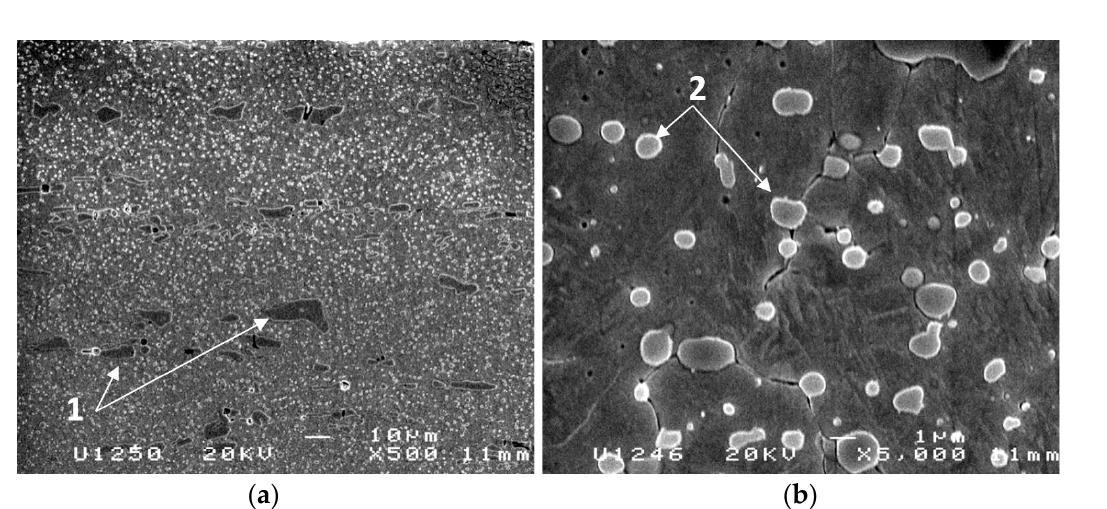
Figure 2. The structure of the material used in research where: ( a ) magnification 500×, 1—primary carbides, ( b ) magnification 5000×, 2—secondary carbides.